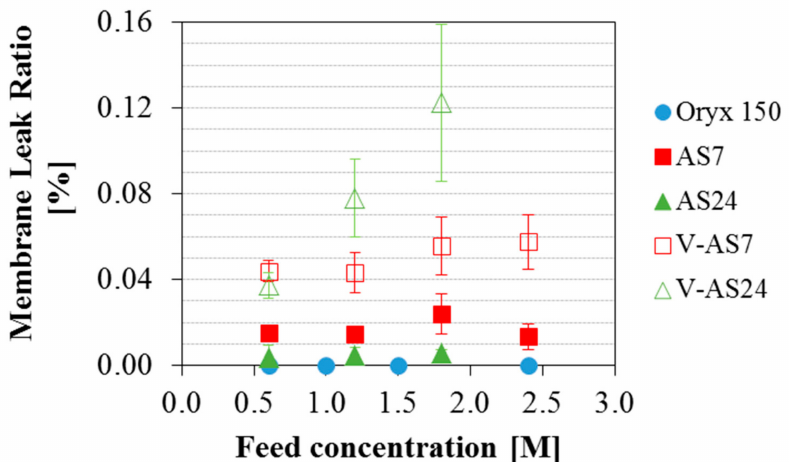
Figure 6. Membrane Leak Ratio obtained with the Oryx 150, the AS7 and the AS24 modules (in AGMD and V-AGMD configuration) for di ff erent initial feed concentrations. T hot = 80 ◦ C; T cold = 25 ◦ C; F = 1100 L · h − 1 (AS modules) and 600 L · h − 1 (Oryx